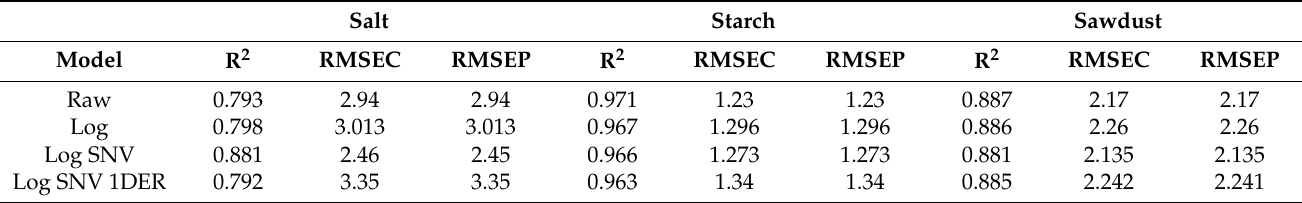
Table 6. Statistical parameters obtained from PLS-R models developed using The Lab software, from spectral data obtained on the SCiO